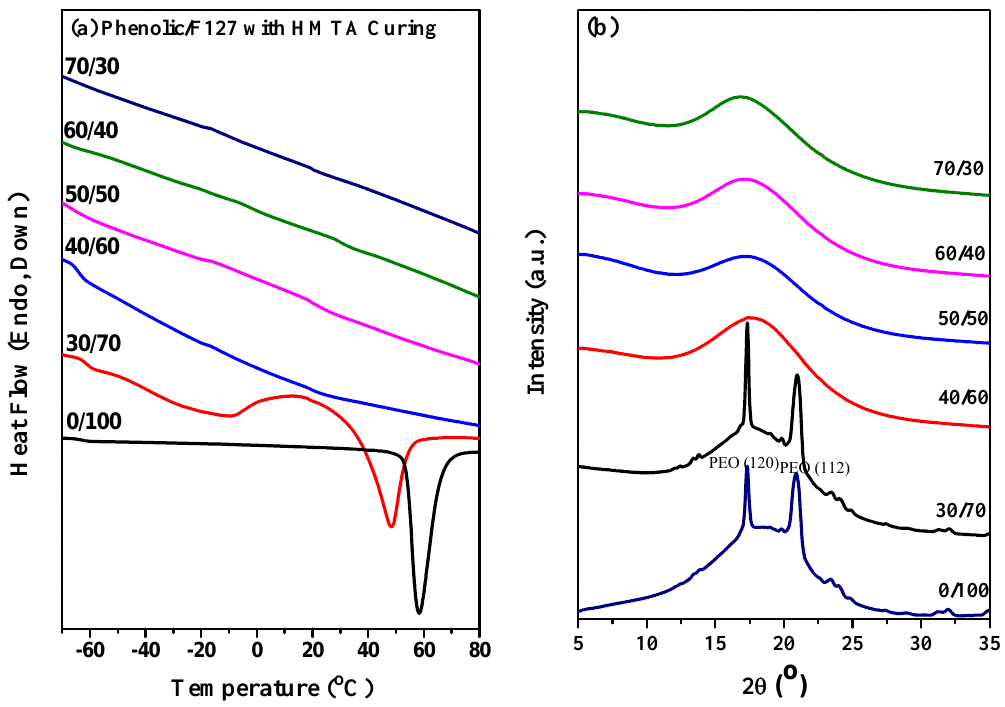
Figure 4. ( a ) DSC thermograms and ( b ) wide-angle X-ray diffraction analyses of phenolic/F127 blends with hexamethylenetetramine (HMTA) curing. PEO, poly(ethylene